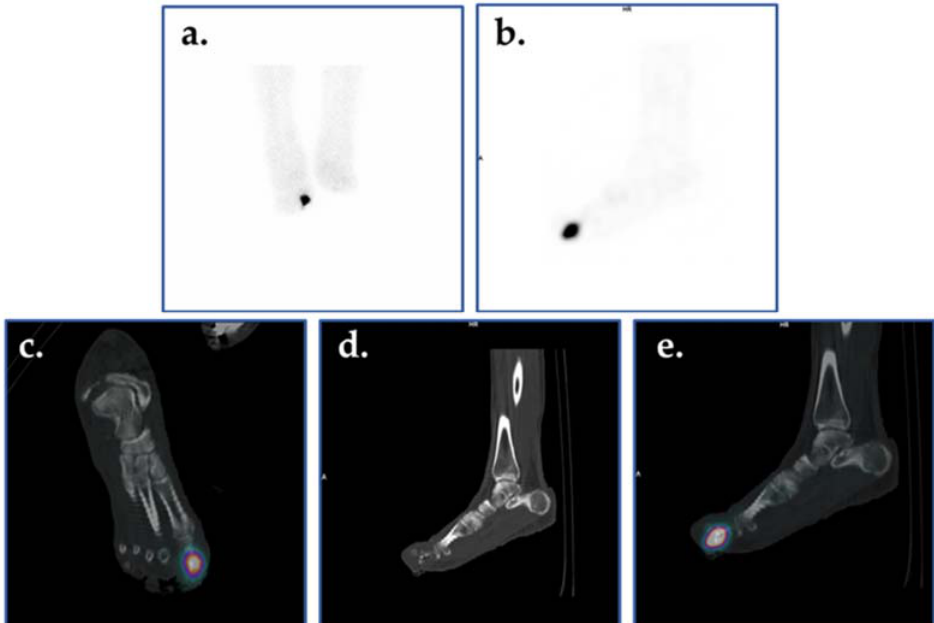
Figure 9. Planar scintigraphic and SPECT/CT 99m Tc-WBC images in an individual with DFI. The patient’s presentation was suspicious for OM involving the great toe. Planar images ( a , b ) demonstrate increased radiolabeled WBCs in the right forefoot, perhaps in the region of the toes. SPECT/CT